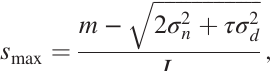
and σ are 4000 v d